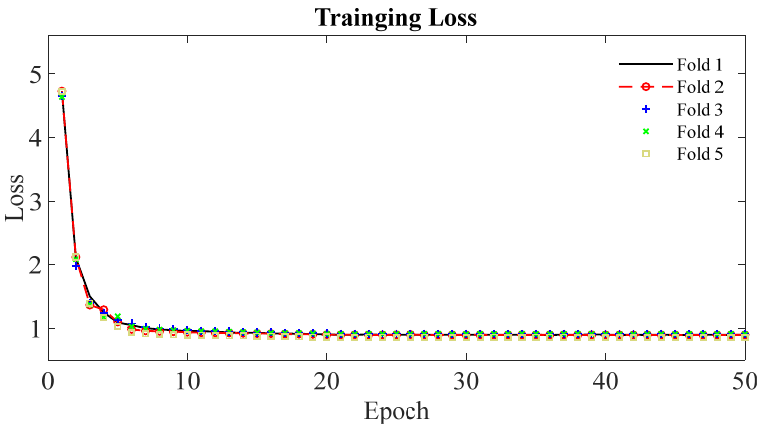
Figure 4. Learning curves of DAF ‐ Net for the 5 ‐ fold cross ‐ validation.